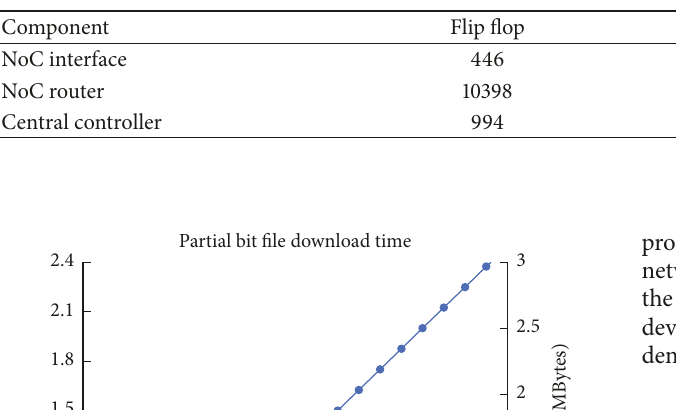
Table 2: Resource utilization.